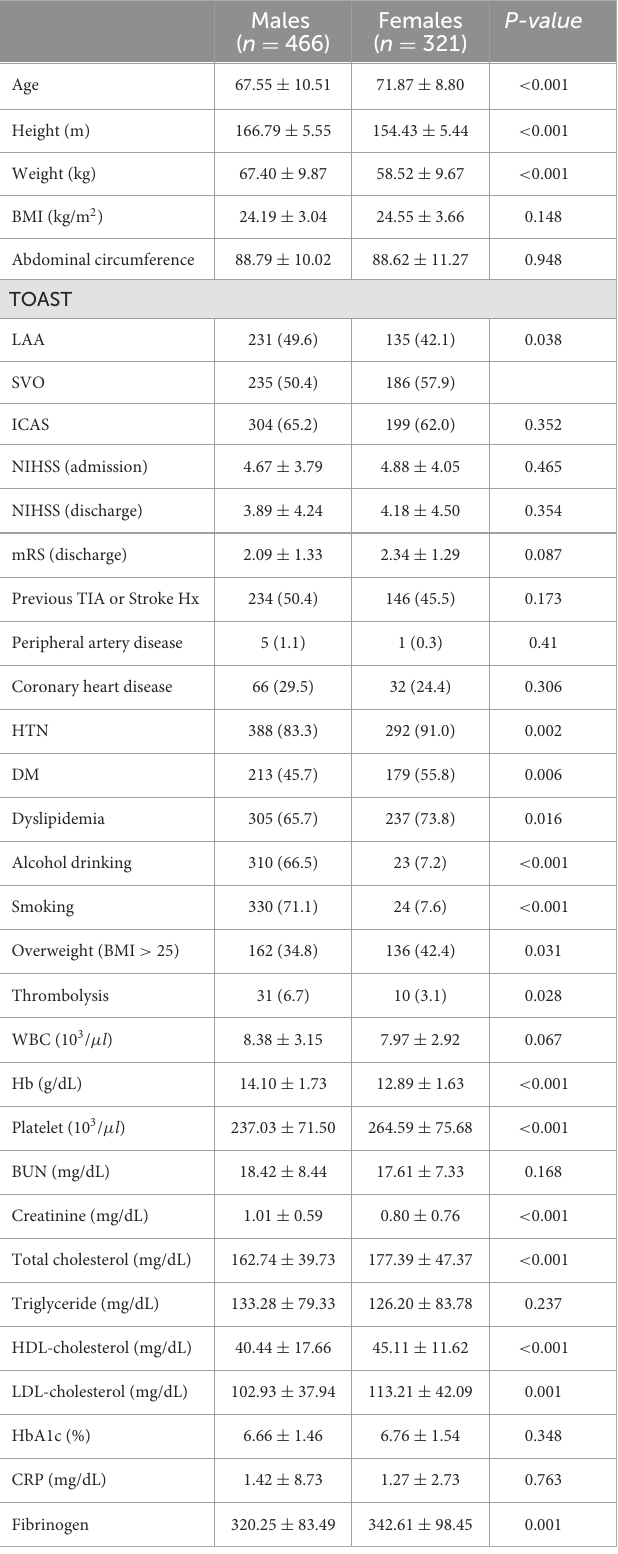
TABLE 1 Comparison of baseline characteristics between males and females patients with recurrent ischemic